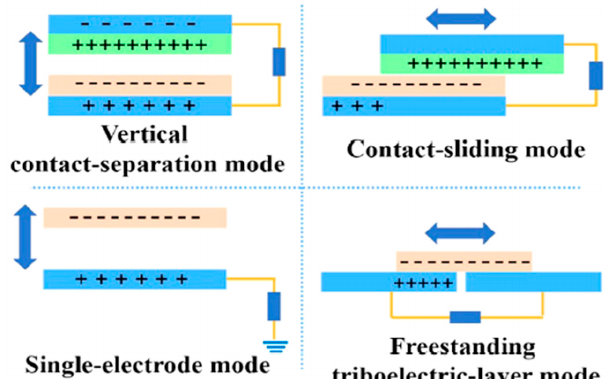
Figure 4. List of triboelectric harvesting modes (Reprinted with permission from Ref. [51]. 2021, IOP Publishing) [51].